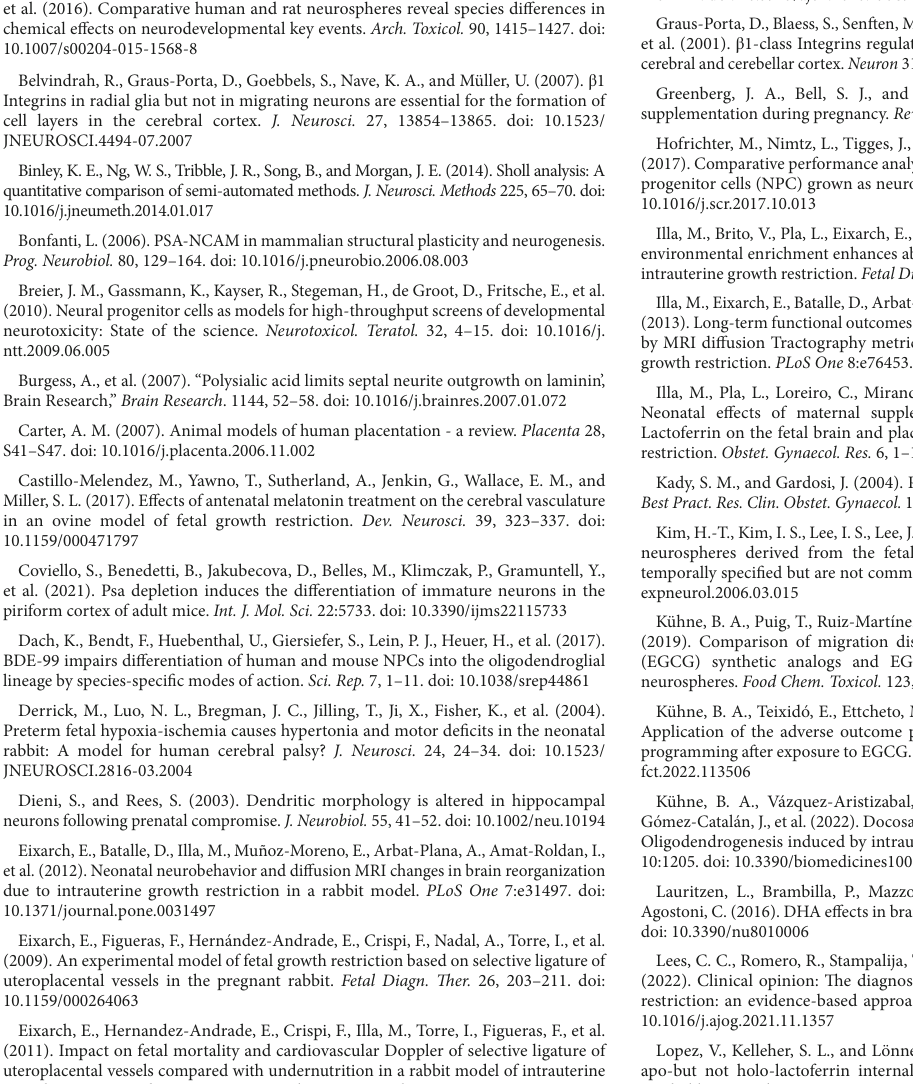
Figueras, F., Caradeux, J., Crispi, F., Eixarch, E., Peguero, A., and Gratacos, E. (2018). Diagnosis and surveillance of late-onset fetal growth restriction. Am. J. Obstet. Gynecol. Figueras, F., and Gratacos, E. (2017). An integrated approach to fetal growth restriction. Best Pract. Res. Clin. Obstet. Gynaecol. 38, 48–58. doi: 10.1016/j.